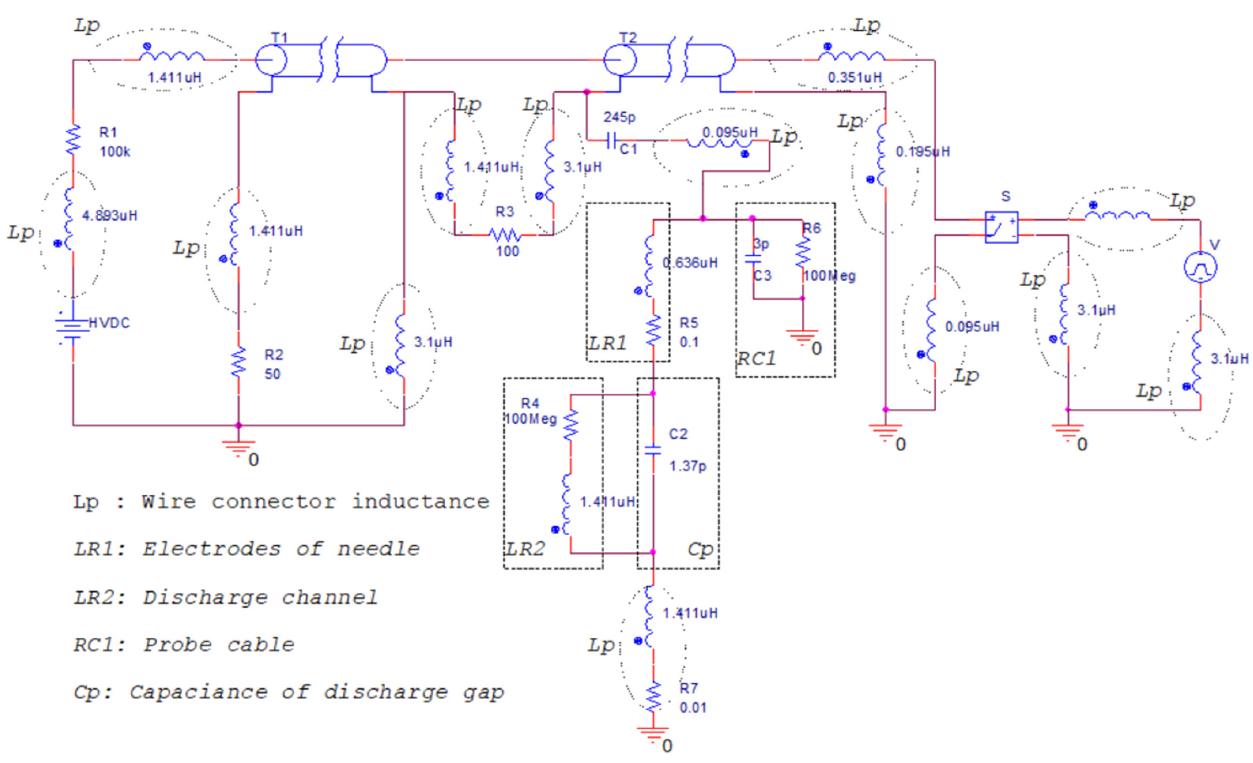
Figure 4. RLC lumped-element model of the Blumlein generator and the test cell.